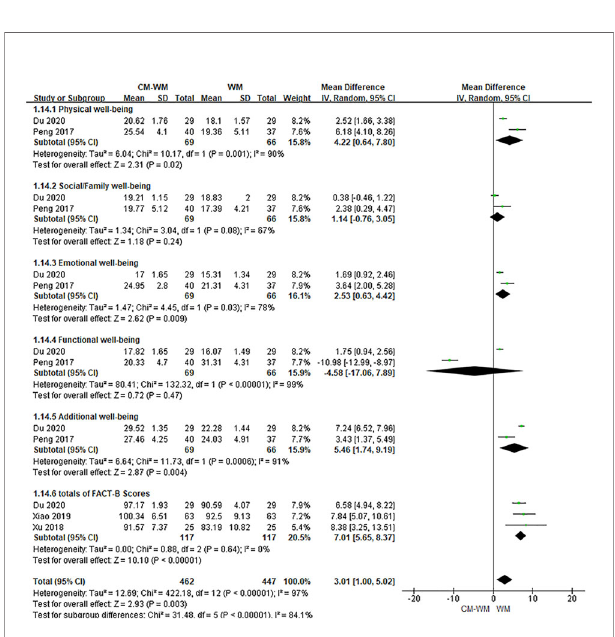
FIGURE 5 | Meta-analyses on FACT-B (CM-WM vs WM).